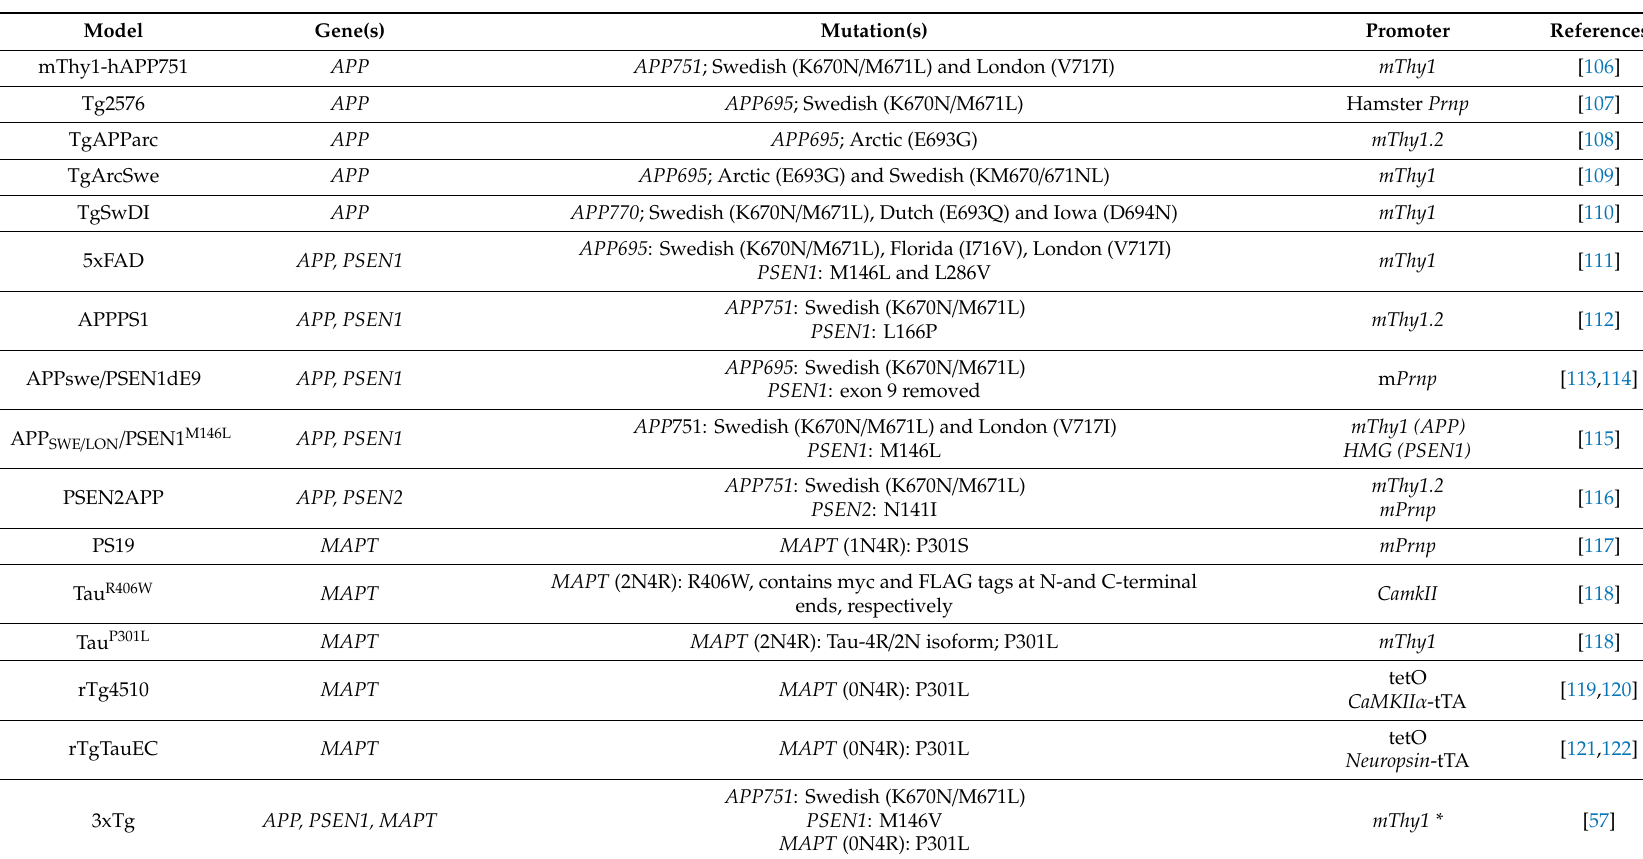
Table 2. Genetic background of FAD mouse models discussed in the review. Late-onset Alzheimer’s disease models are not included here, as the genetic manipulation is indicated in the model’s name (e.g., human GFAP-APO ε 4 = APO ε allele 4 driven by the GFAP promoter). APP695, 751, and 770 refer to di ff erent APP isoforms generated by alternative splicing of exons 7 and 8. * All mice are transgenic, except for 3xTg, where PSEN1 was knocked-in. For additional information on these models and the models in Supplementary Tables S1–S3, please visit (https: // www.alzforum.org / research-models / alzheimers-disease). For ease of reading, we will refer to the shortened model name (left hand column) throughout the review. Addition synonyms can be found at